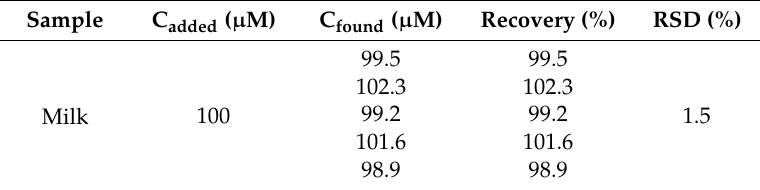
Table 2. Recovery experiment of detection of H 2 O 2 in milk